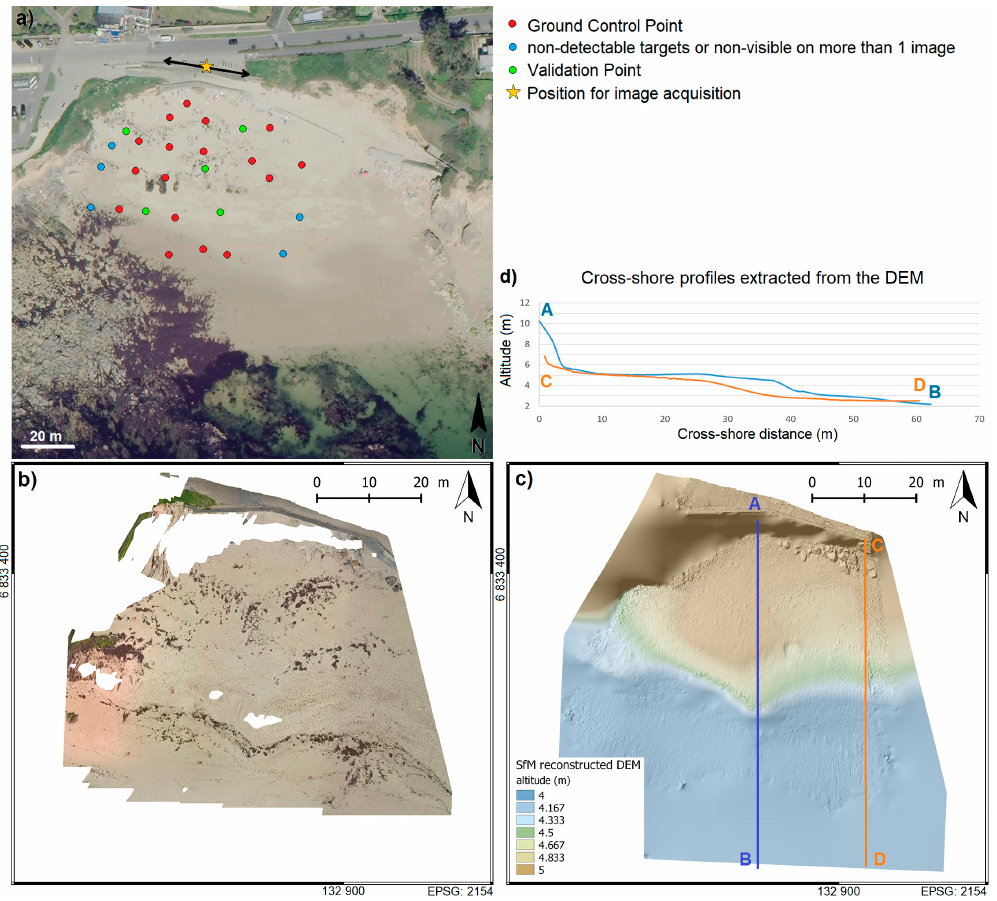
Figure 11. ( a ) Configuration of the Trégana Beach survey by smartphone SfM photogrammetry, using the Lumia 930 (Background image: BD Ortho—IGN©). Orthophotograph ( b ) and DEM ( c ) obtained by SfM processing. ( d ) Cross-shore profiles extracted from the smartphone photogrammetric DEM.